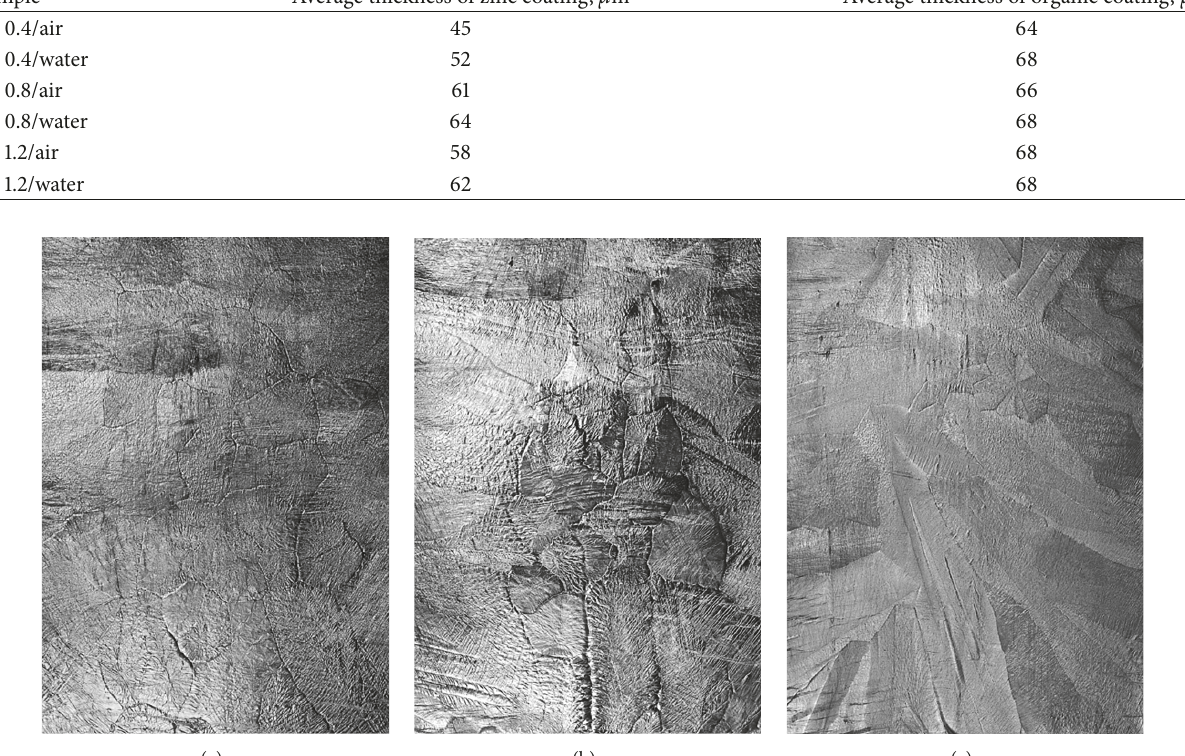
Figure 1: Visual appearance of air-cooled hot-dip galvanised surfaces: (a) Pb 1.2, (b) Pb 0.8, and (c) Pb